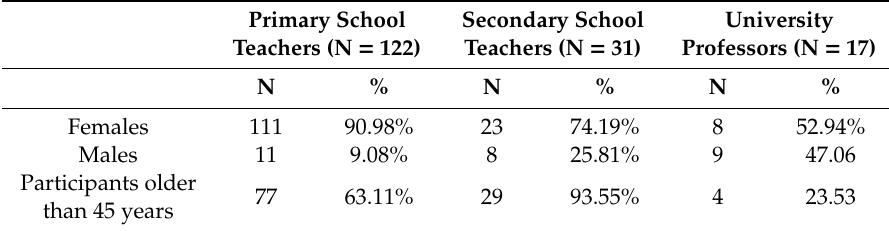
Table 1. Characteristics of the participants.